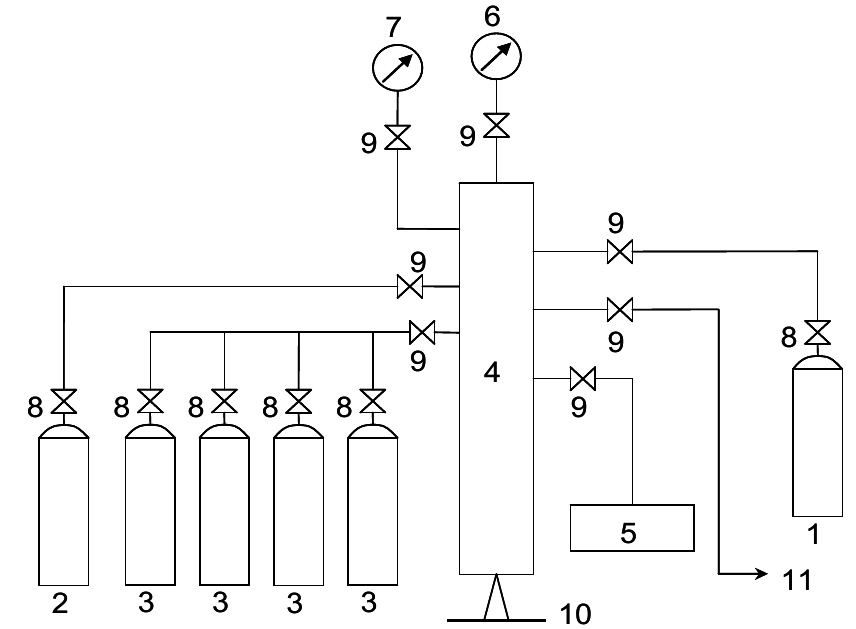
Figure 2. Schematic of the gas mixing device. (1) Pure methane; (2) compressed air bottle; (3) mixed gas bottle; (4) high pressure chamber; (5) vacuum pump; (6) vacuum meter; (7) pressure gauge; (8) gate valve; (9) hand valve; (10) bracket; and (11) gas delivery pipe.